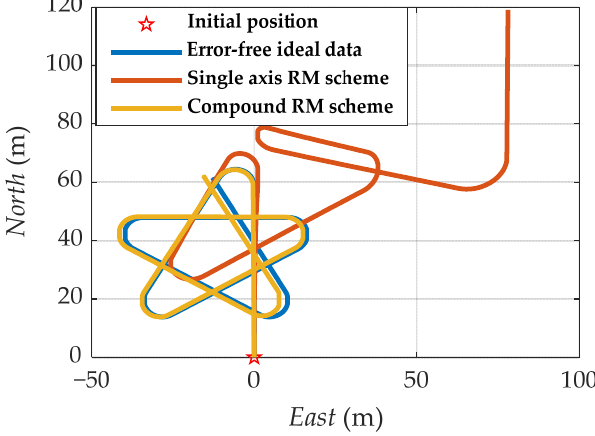
Figure 17. Comparison of trajectories obtained by navigation solution.